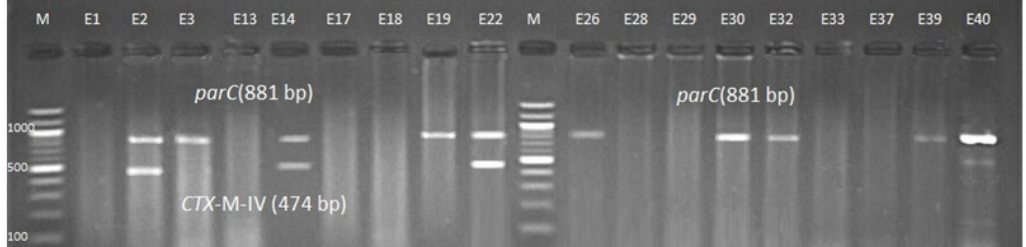
Fig. 6. 1.5% Agarose gel electrophoresis at 72 volt for 90 minutes of PCR to blaCTX-M-IV amplicon (474bp) lane M represent DNA marker size(100bp) while E1-E40 represent the